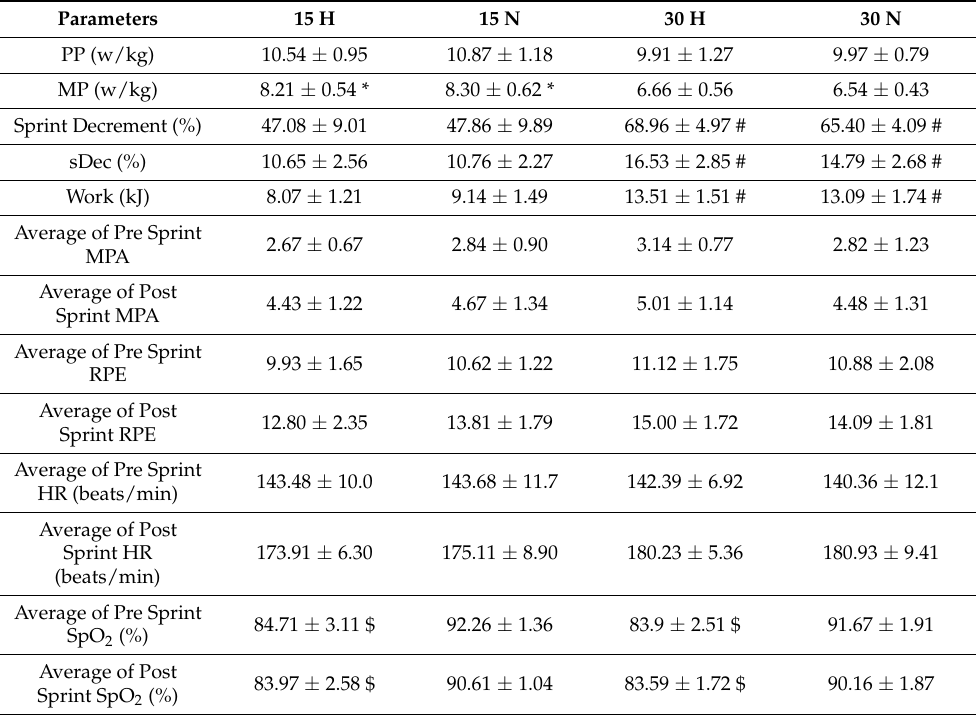
Table 4. Average of 4 weeks (12 sessions in total) of training